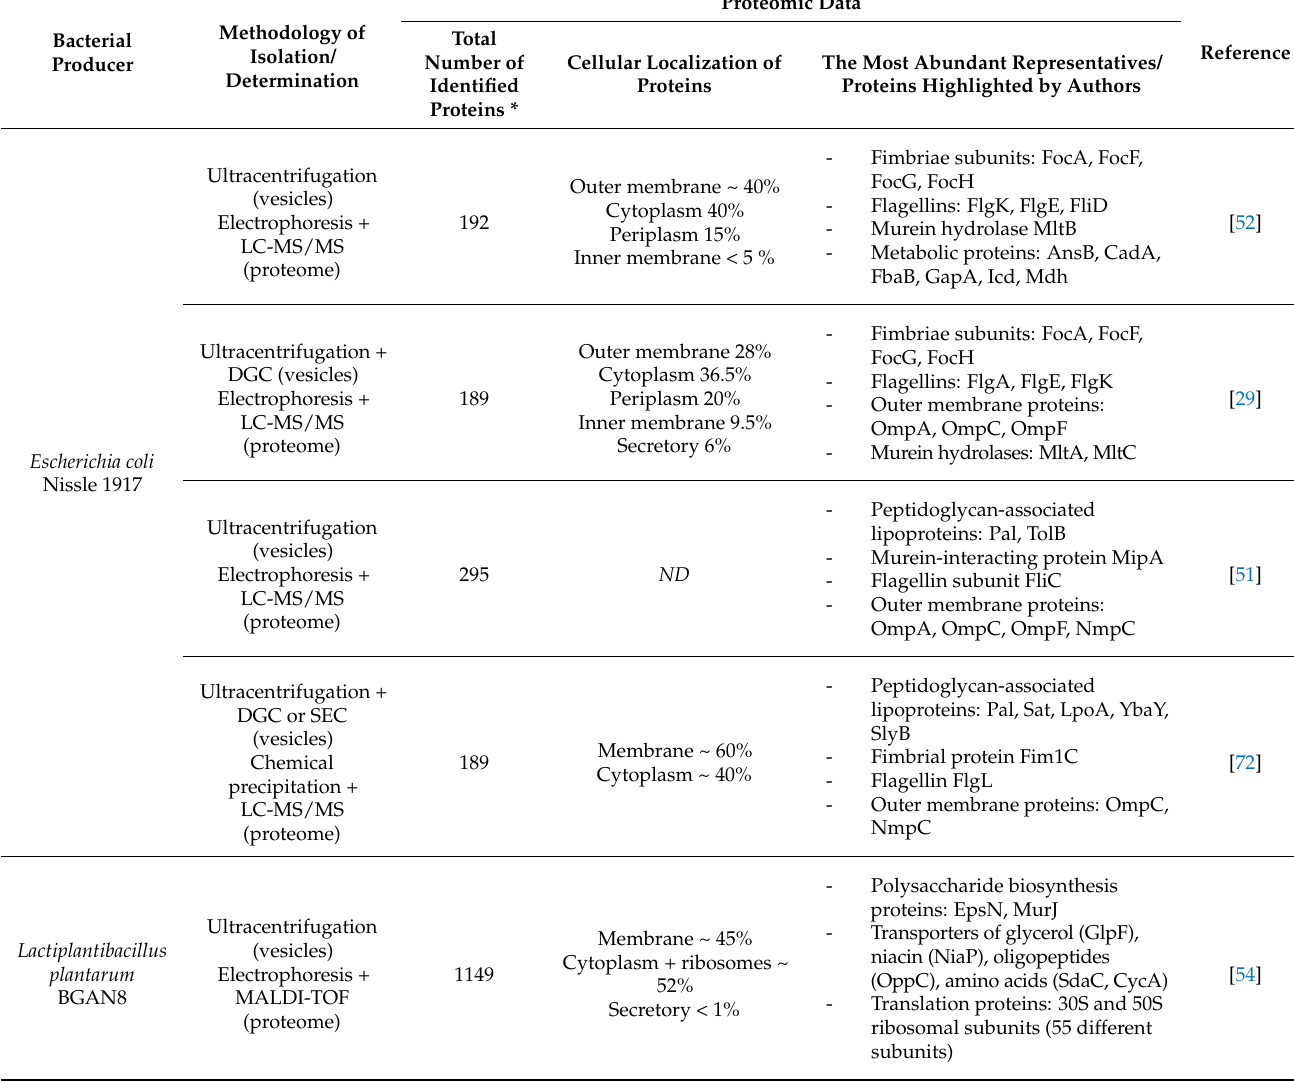
Table 1. Proteomic data on extracellular vesicles produced by